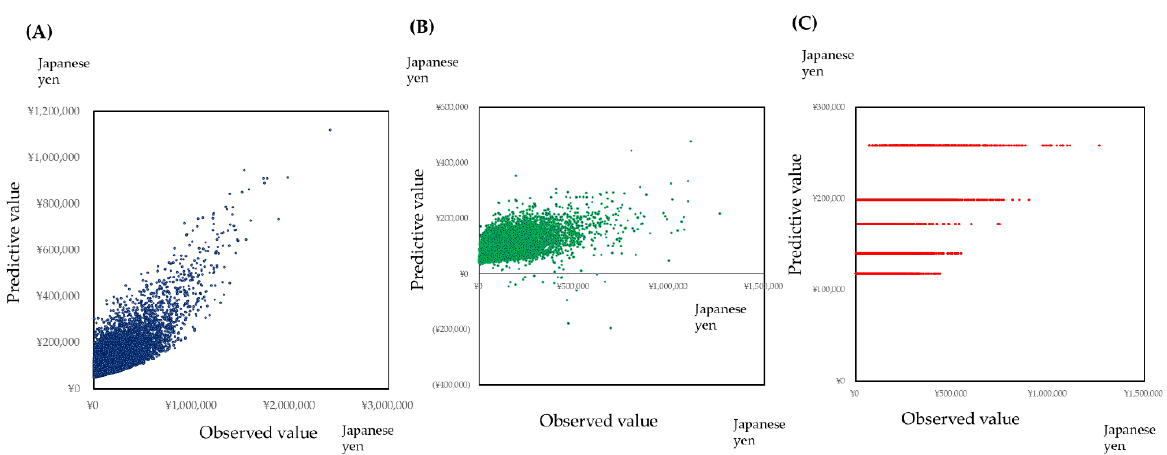
Figure 4. Neural network model for the prediction of medical healthcare cost.